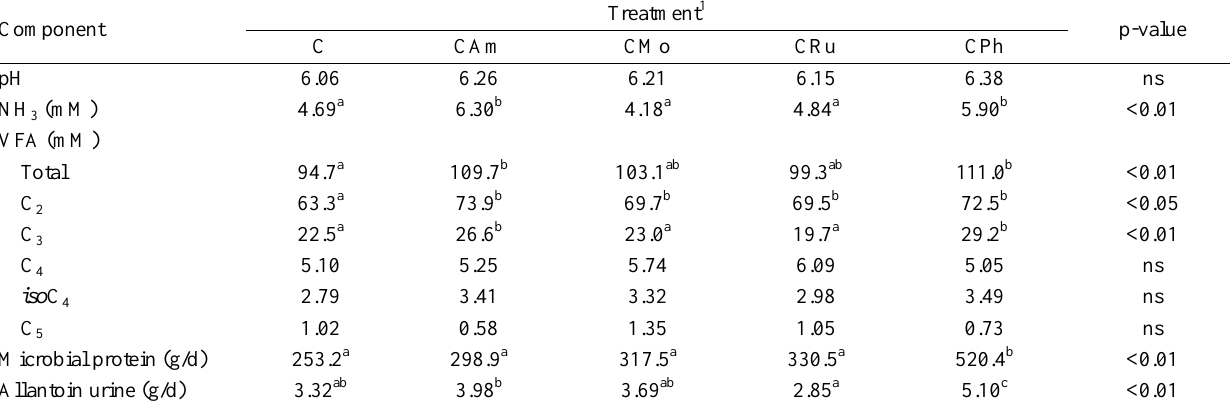
Table 5. Influence of various chemical and biological treatments of cocoa pod on rumen fermentation parameters of steers (n = 5)